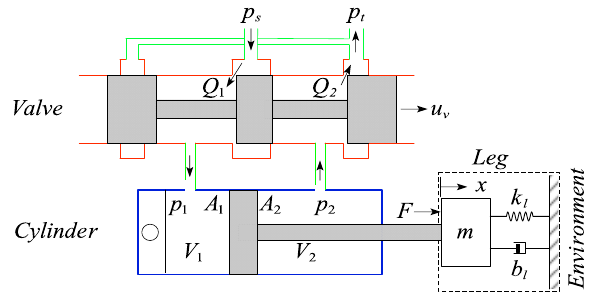
Figure 4. Overview of the hydraulically actuated quadruped robot system. ( a ) National Instru- ment ® -based controller; ( b ) prototype of the hydraulically actuated quadruped robot.